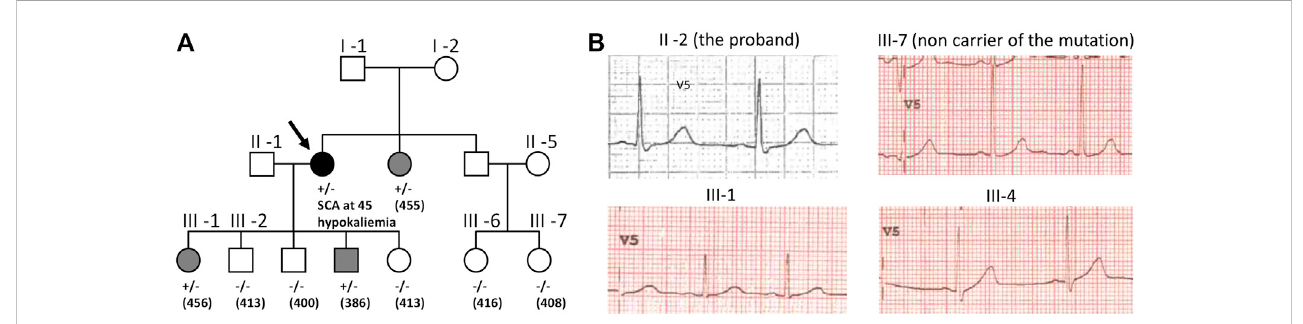
FIGURE 1 (A) Family pedigree harboring the c.2504G > C p.Arg835Pro KCNH2 mutation that leads to hERG loss of function (Oliveira-Mendes et al., 2021). The proband(arrow)presentedasuddencardiacarrest(SCA)duetoventricular fi brillationat45duringanepisodeofhypokalemiarequiringanimplantablecardiac de fi brillator (ICD). Post-Resuscitation ECG was normal. Family members cascade screening detected the KCNH2 variation in her sister and two children III-1 and III-4; QTc interval values (in ms) are shown between parentheses. Squares depict male subjects; circle, female subject; open symbols, unaffected members; solid black symbol, affected members; grey symbol, mild phenotype. (B) ECG tracings in lead V5 of the proband (II-2), a non-carrier niece (III-7), a daughter (III-1) and a son (III-4) who are both carriers of the variant and showing mild LQT2 phenotype (T waves: low amplitude amplitude for III-1 and very slightly bi fi d for